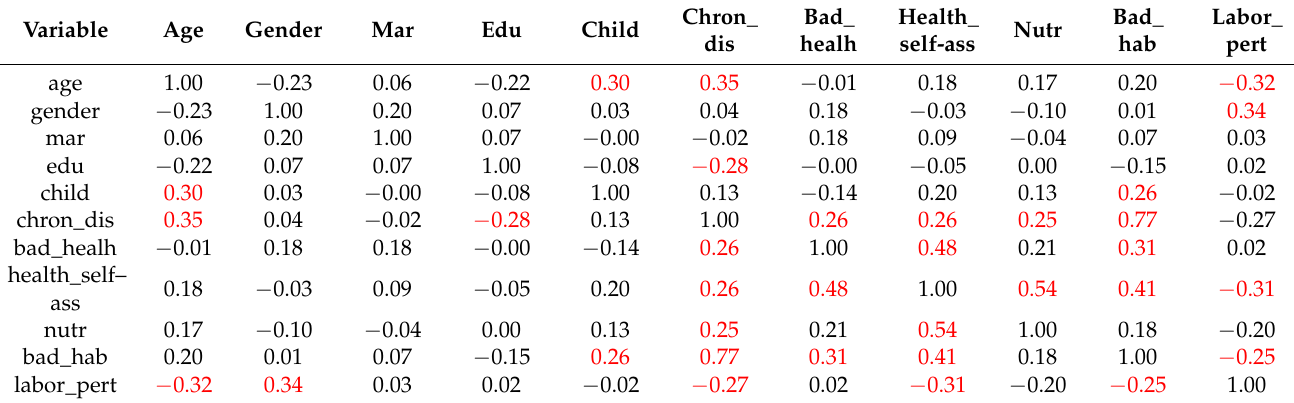
Table 3. Partial correlations of factors (significant parameters are marked in